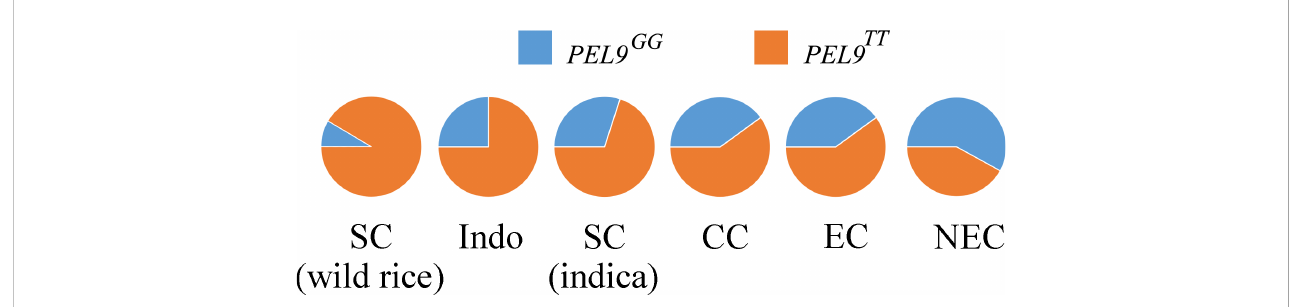
FIGURE 6 The gene allele frequency differences at the causal polymorphisms of PEL9 in six geographic groups. The G allele indicates the type of reference allele. The T allele indicates the type of alternative allele. Indo, Indonesia; SC, southern China; CC, central China; EC, eastern China; NEC, northeastern China. The wild rice accessions were mainly from southern China. The accessions from Indo were mainly tropical japonica subspecies. The accessions from SC and CC were mainly indica subspecies. The accessions from EC and NEC were mainly temperate japonica